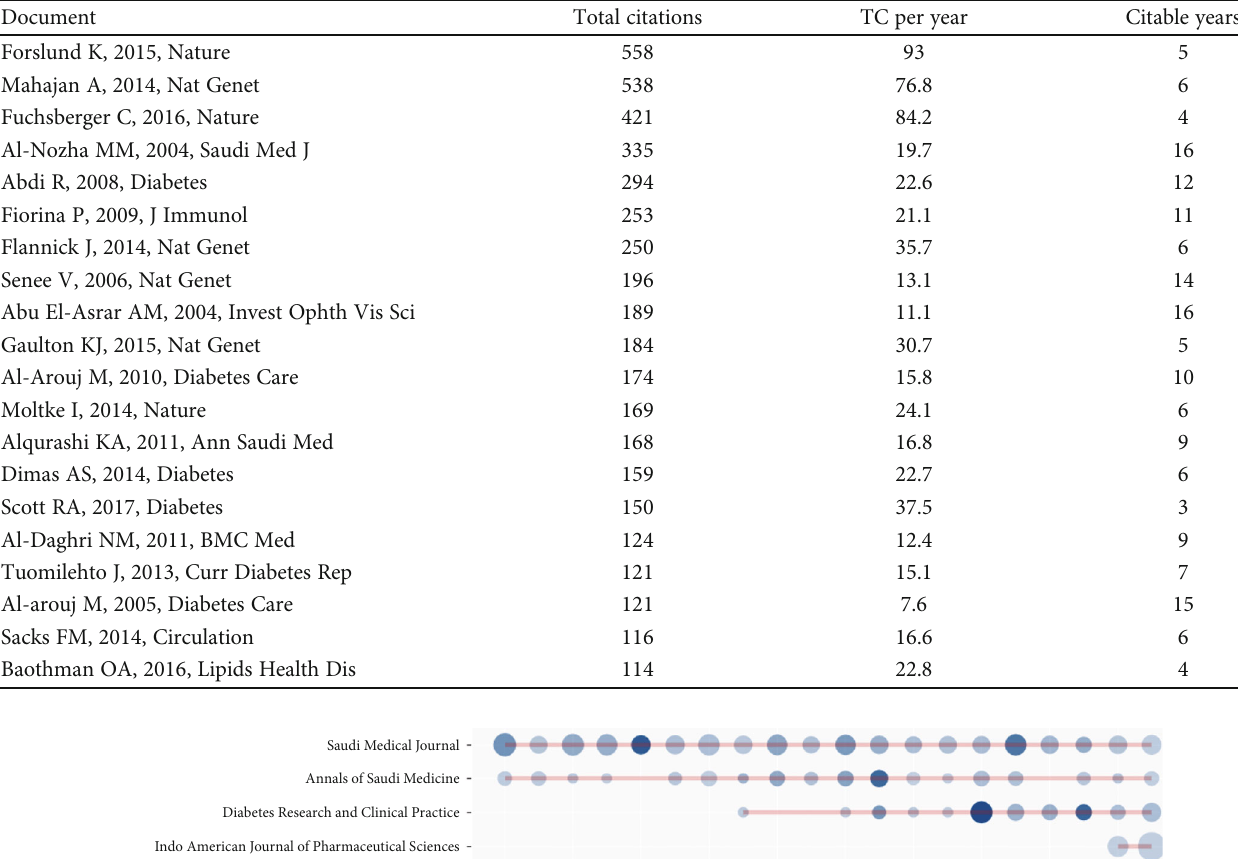
Table 4: Top 20 highly cited documents.